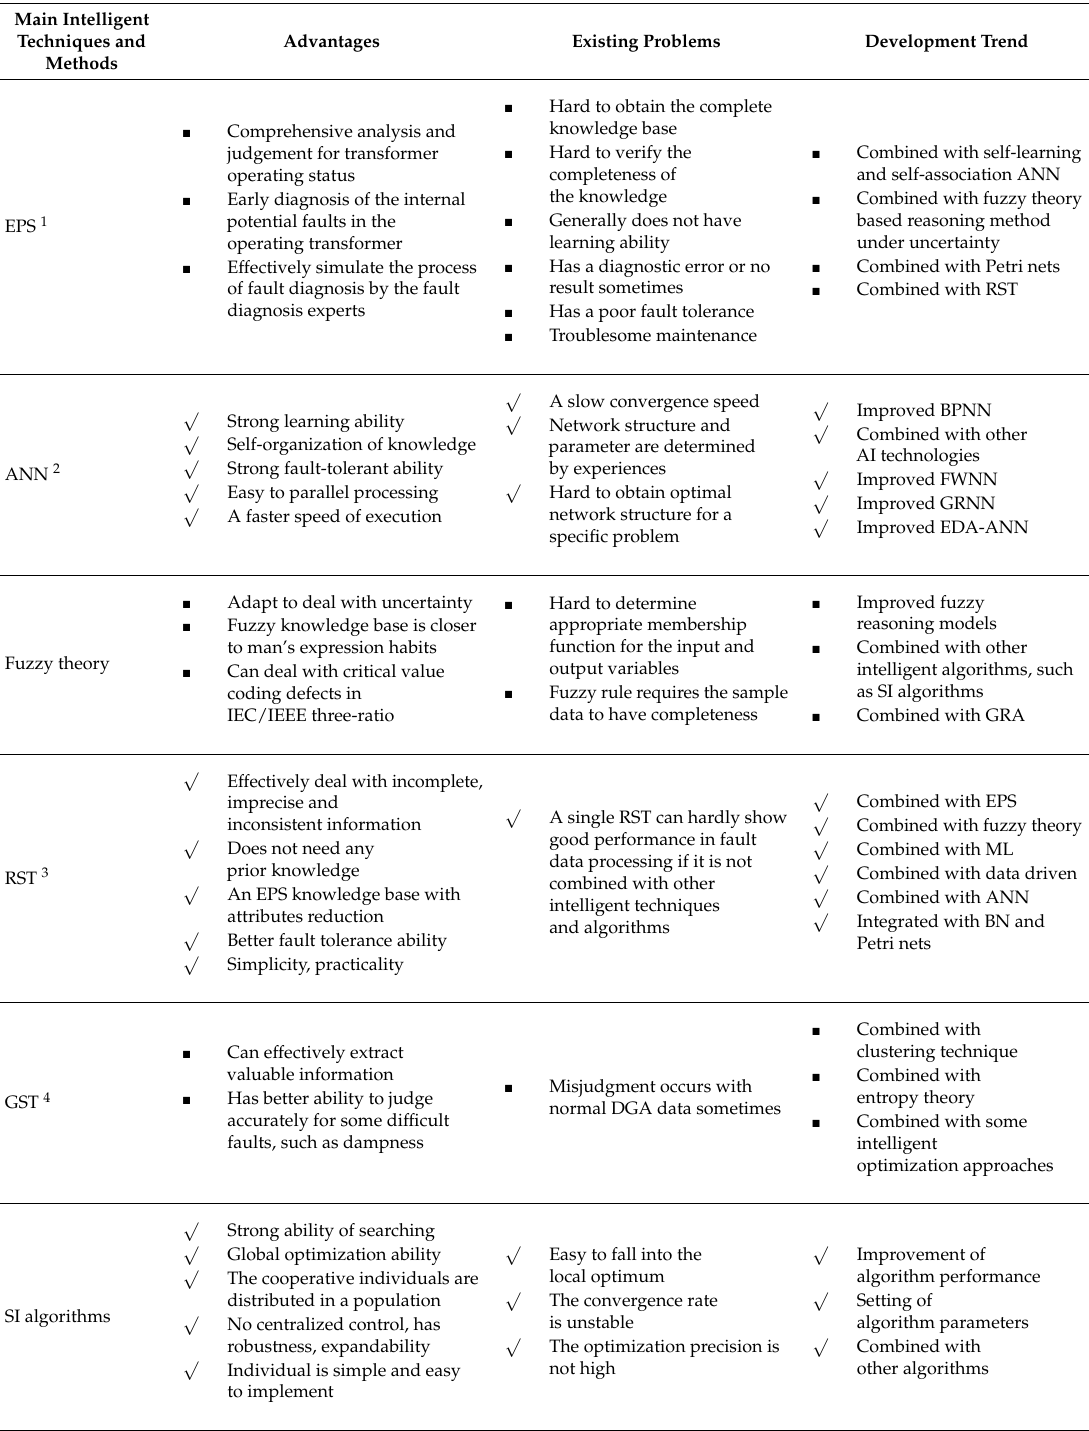
Table 12. A brief summary of the main advantages, existing problems and development trend of the main intelligent techniques and methods summarized in this paper in transformer fault diagnosis using DGA